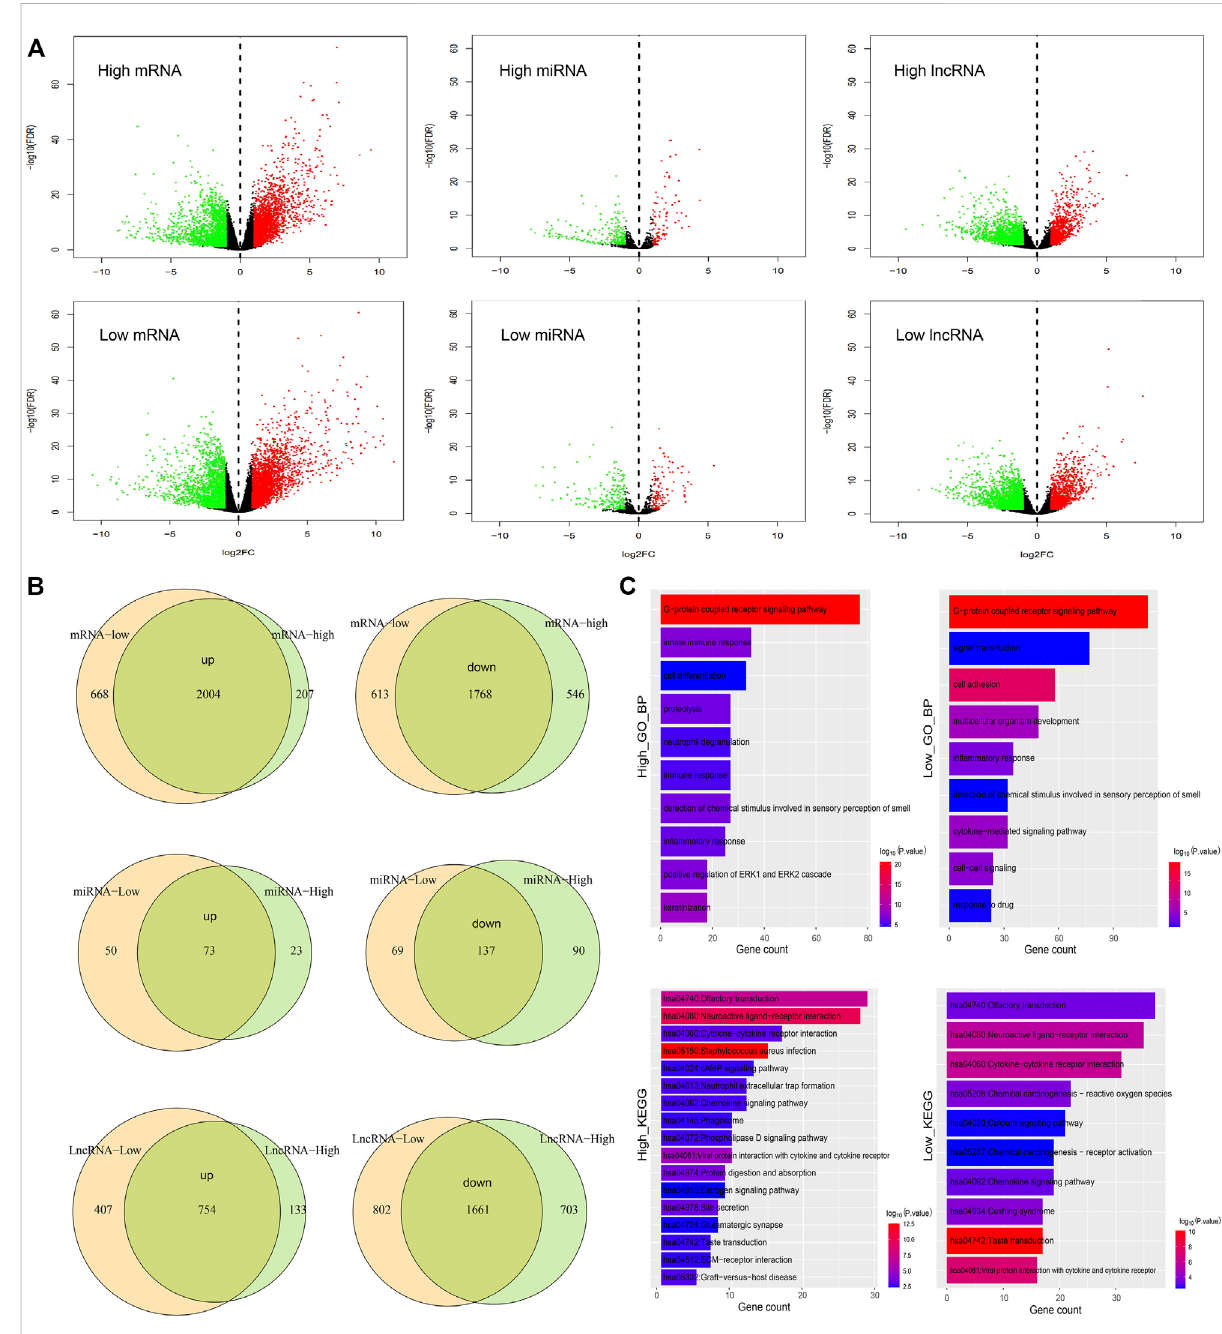
FIGURE 5 Comparison ofsamplesinhighandlowlatitudesatthetranscriptomelevel. (A) DifferentialexpressionofmRNAs,miRNAs,andlncRNAsinhigh- and low-latitude samples. Green and red dots represent the downregulated and upregulated RNAs in cancer samples. (B) Overlap of differential upregulated and downregulated mRNAs, miRNAs, and lncRNAs in two sample groups. (C) Functional enrichment of mRNAs with differential expression especially in high or low